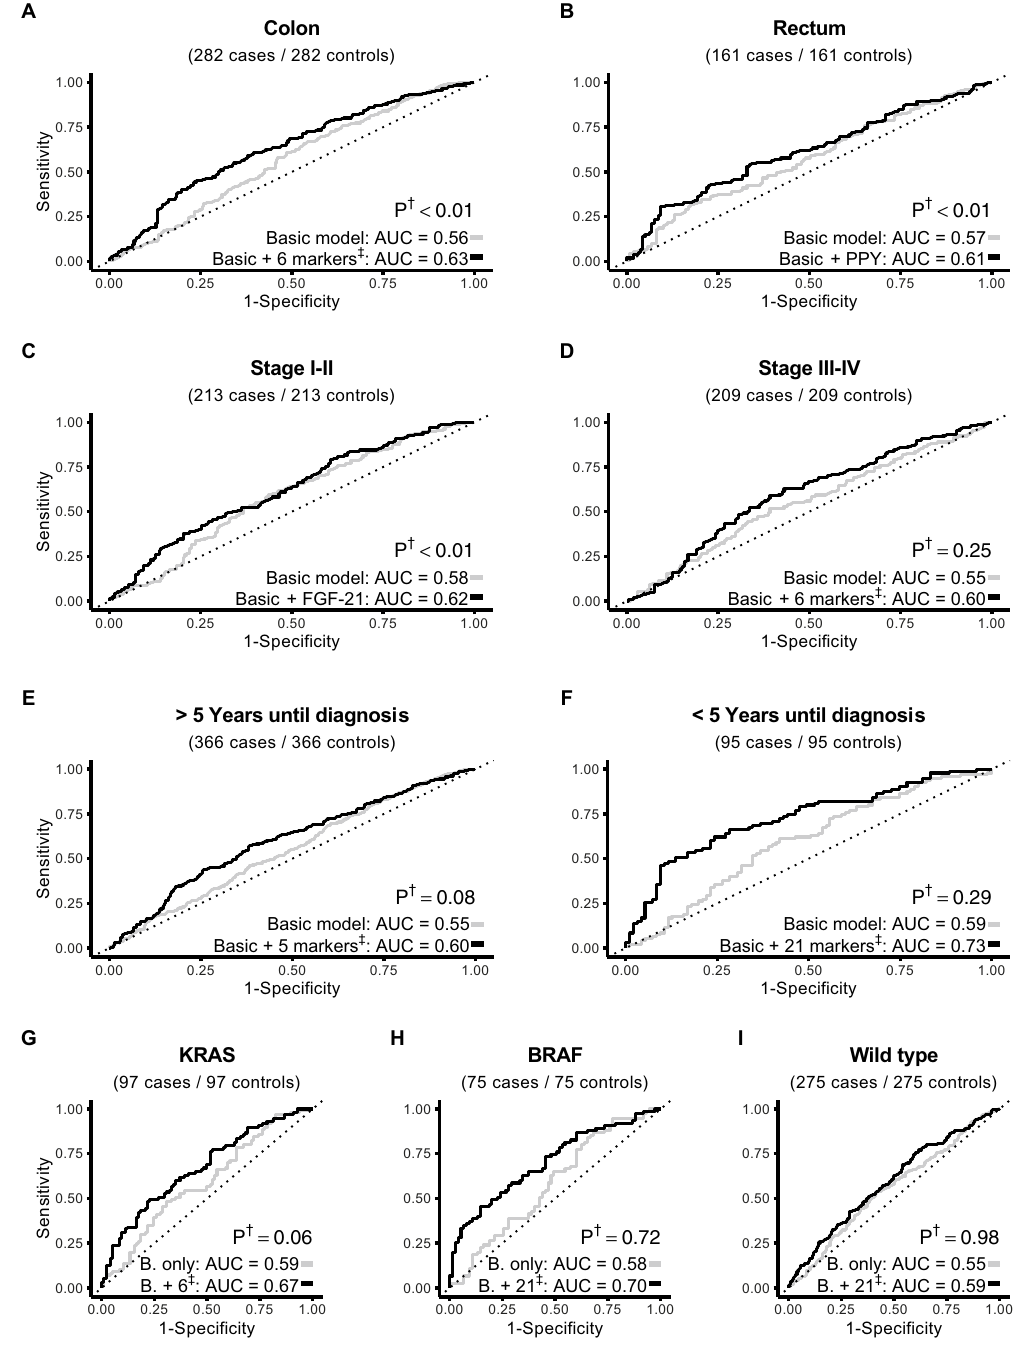
Figure 3. ROC curves for stratified analyses comparing Colon and Rectum ( A , B ), Stage I–II and Stage III–IV ( C , D ), years until diagnosis ( E , F ) and molecular subtypes ( G – I ). All models were adjusted for smoking status, BMI, level of education, age and sex. For complete protein panels see Supplementary Table S5. † Based on the loglikelihood ratio test between the two models. ‡ Selected proteins are listed in Supplementary Table